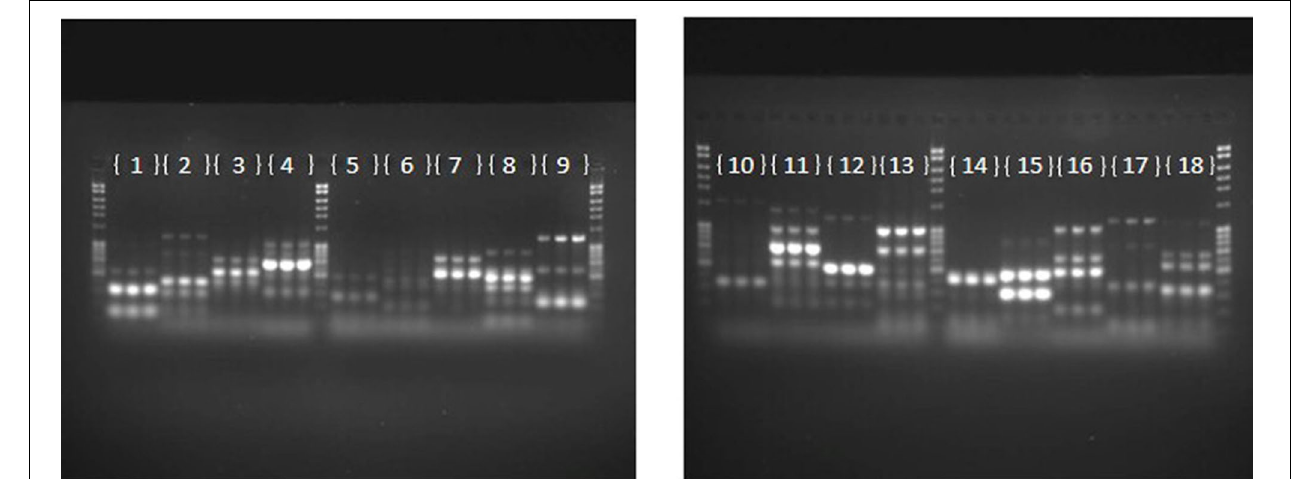
FIGURE 1 | Repeatability of the fingerprinting technique. Each number represents a type strain analyzed in triplicate. (1) Halorubrum arcis JCM 13916 (2) Halorubrum coriense DSM 10284 (3) Halorubrum distributum JCM 9100 (4) Halorubrum ejinorense JCM 14265 (5) Halorubrum lacusprofundi ATCC 49239 (6) Halorubrum lipolyticum DSM 21995 (7) Halorubrum litoreum JCM 13561 (8) Halorubrum saccharovorum DSM 1137 (9) Halorubrum